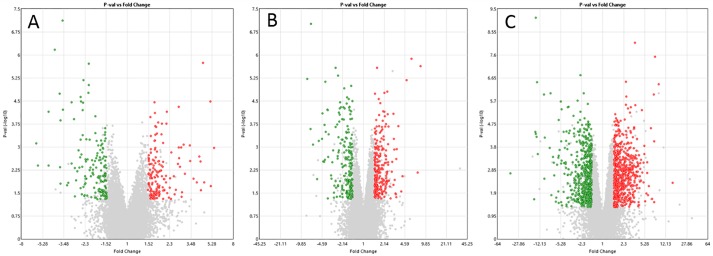
Volcano plots comparing qVICs to aVICs and the effect of treatments on VICs.Red dots represent up-regulated genes, green represent genes that were down-regulated and uncoloured are genes which do not pass the differential expression criteria. The X-axis shows fold change value and the Y-axis shows the P-value. (A) Genes differentially expressed between qVICs + vehicle and qVICs treated with TGFβ1. (B) Genes differentially expressed between aVICs + vehicle and aVICs treated with SB431542. (C) Differentially expressed genes between qVICs and aVICs. Statistical analysis was performed with paired or unpaired ANOVA.